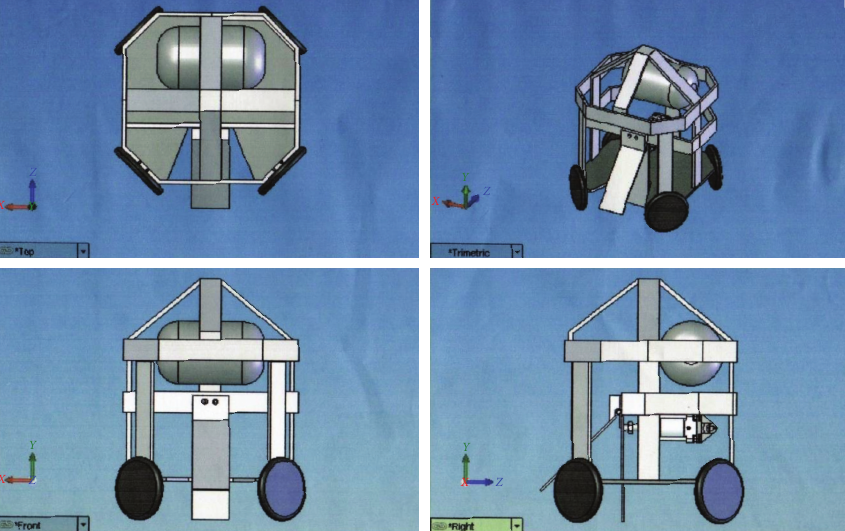
Figure 8: 3D CAD drawing for the final modified design.